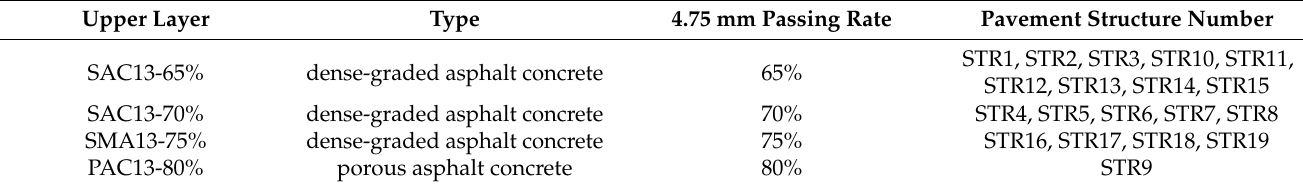
Table 1. Asphalt upper layer information and pavement structure number of RIOHTrack.